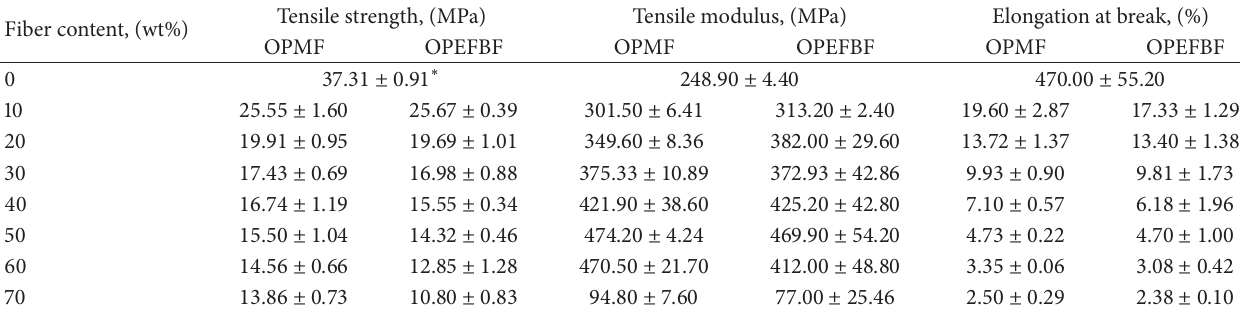
Table 3: Tensile strength, tensile modulus, and elongation at break of PBS, PBS/OPMF, and PBS/OPEFBF biocomposites. Tensile strength, (MPa) Tensile modulus, (MPa) Elongation at break, (%) Fiber content, (wt%)